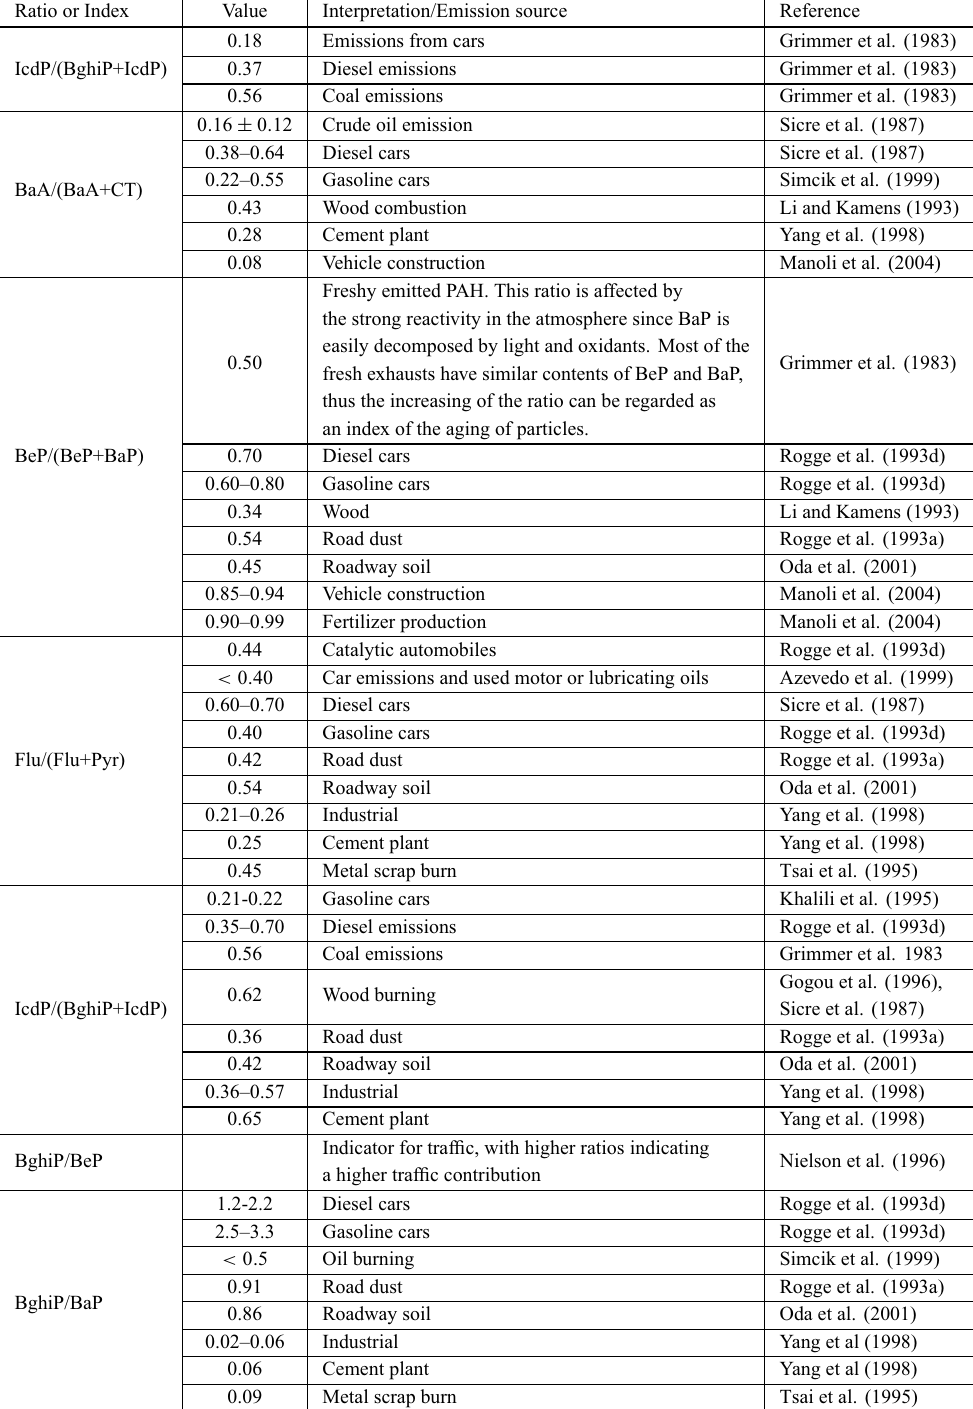
Diagnostic ratios between PAH reported in the